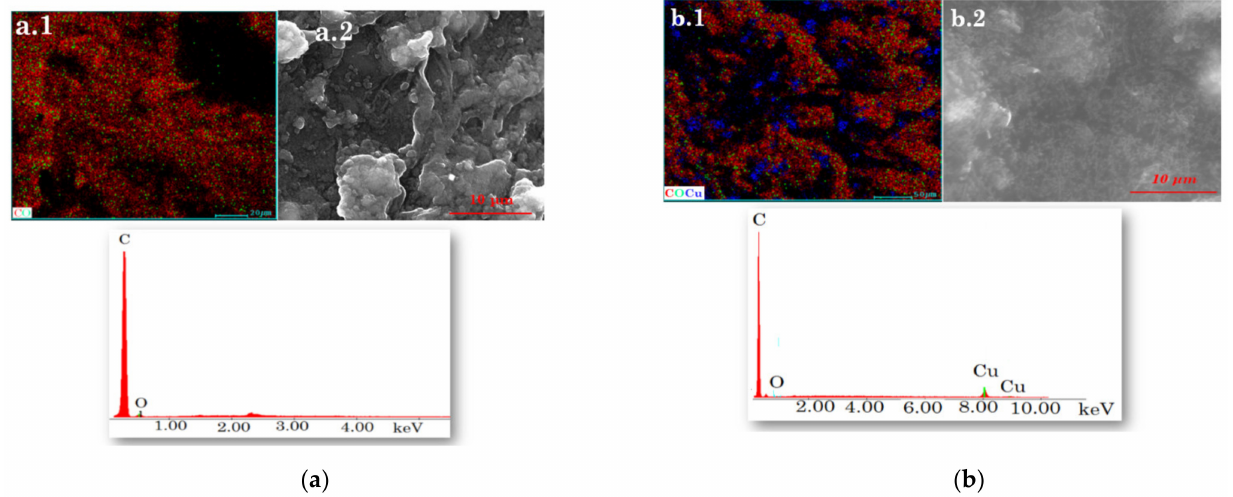
Figure 3. Elemental mapping ( a.1 , b.1 ), surface morphology ( a.2 , b.2 ), and EDX spectrum of the pastes based on: ( a ) CuAuNP-PIX/SWCNT and ( b )